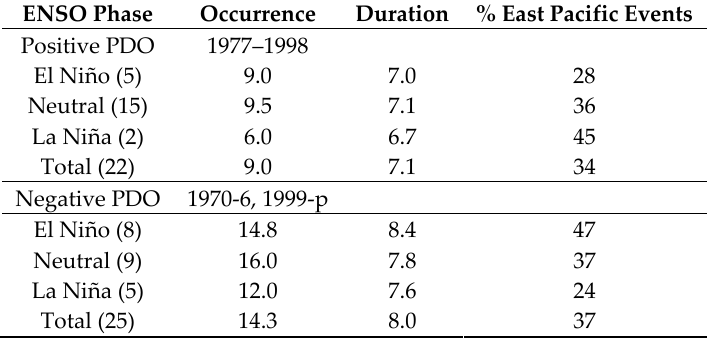
Table 3. Character of Southern Hemisphere blocking with respect to ENSO and PDO following